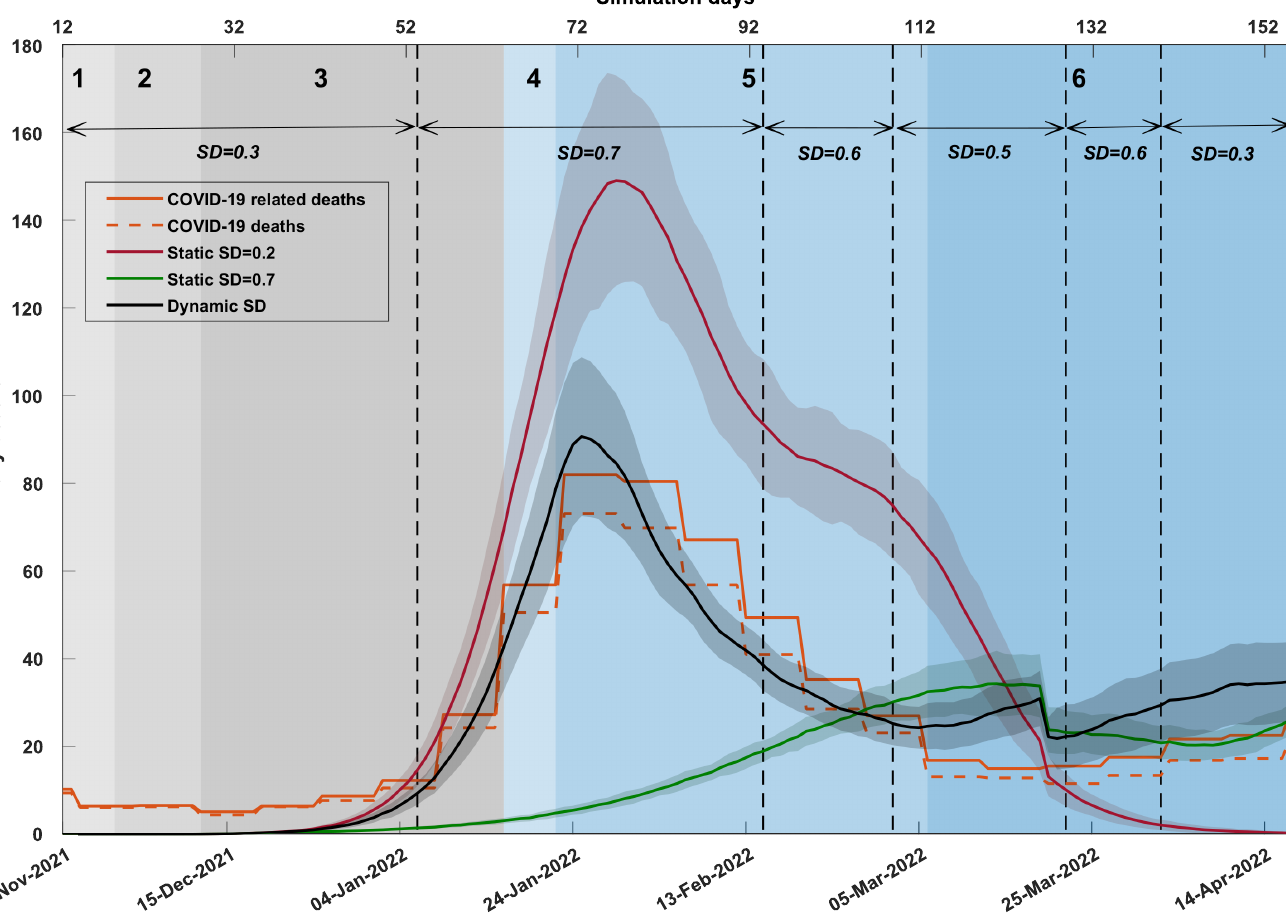
Fig 5. A comparison of daily deaths produced by different social distancing (SD) profiles. The plot contrasts dynamic social distancing (SD) levels (shown in solid black) and static SD levels ( SD 1 = 0.2, shown in red; SD 2 = 0.7, shown in green). The simulated daily deaths are offset by 14 days. Coloured shaded areas around the solid line show standard deviation. Changes in dynamic SD-adoption are marked by vertical dashed black lines. Traces corresponding to each simulated scenario are computed as the average over 20 runs. SD adoption is combined with other interventions (i.e., school closures, case isolation, and home quarantine). Actual daily deaths are derived from reported weekly deaths (shown in orange; solid: COVID-19 related deaths; dashed: COVID-19 deaths). Shaded areas in grey and blue show the emergence of variants of concern and sub-lineages over time, identified in weekly genomic surveillance reports (NSW Health). The timeline is divided into 6 phases as follows: 1) BA.1 detected, 2) Delta and BA.1 co-exist, 3) BA.1 dominant, 4) BA.2 detected, 5) BA.1 and BA.2 co-exist, and 6) BA.2